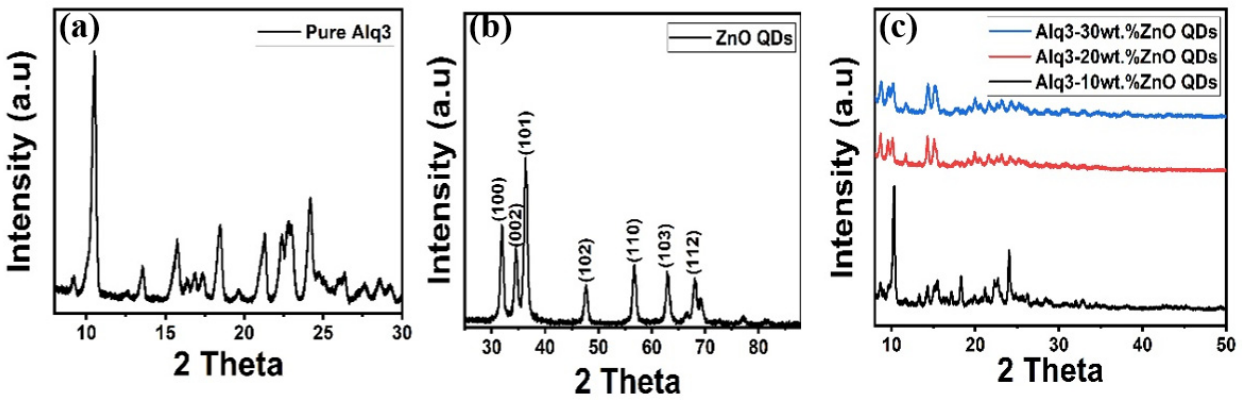
Figure 1. XRD pattern of ( a ) pure Alq3, ( b ) ZnO QDs and ( c ) Alq3-ZnO nanohybrids.